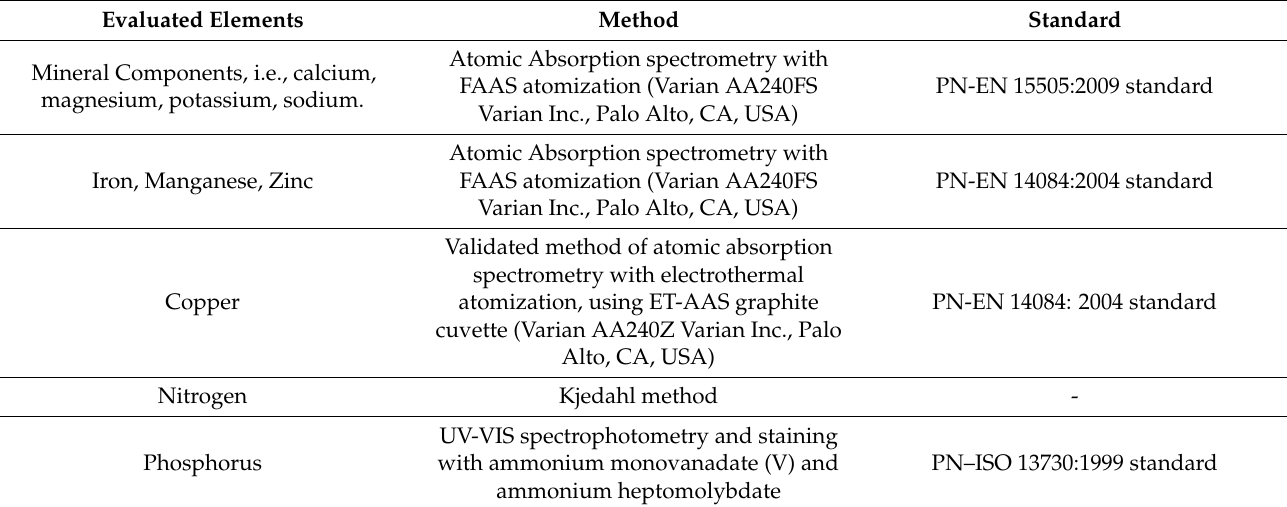
Table 4. Methods to determine the content of specified elements in their